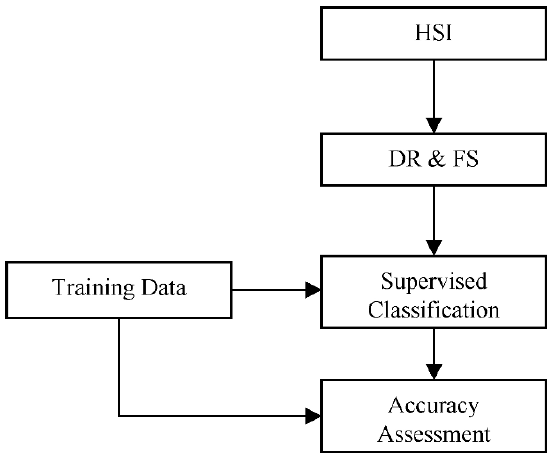
Figure 1. Image Classification Module.